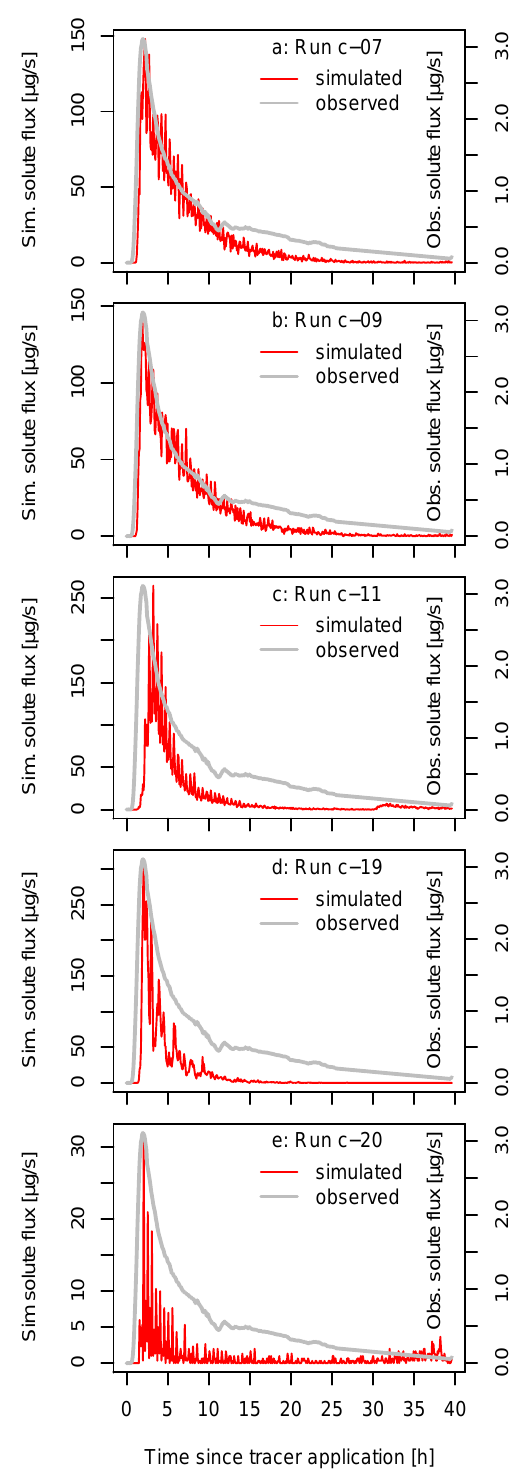
Fig. 4. (a–e) Solute breakthrough curves of the five basic set-ups with acceptable water flow simulation in comparison with the ob- servation. Time is given as hours since tracer application; please note the different scales for simulated and observed solute